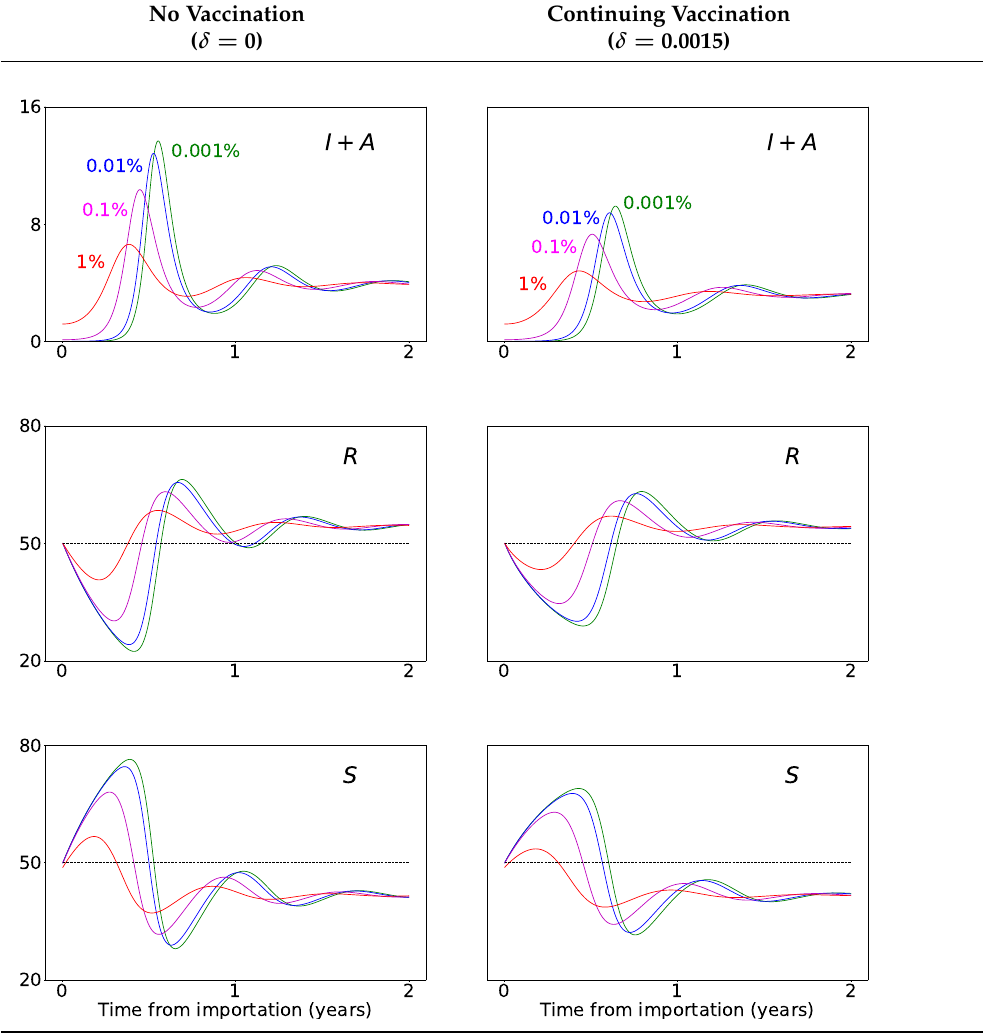
Table 2. Time evolution of infected ( I + A ), removed ( R ), and susceptible ( S ) populations. No Vaccination